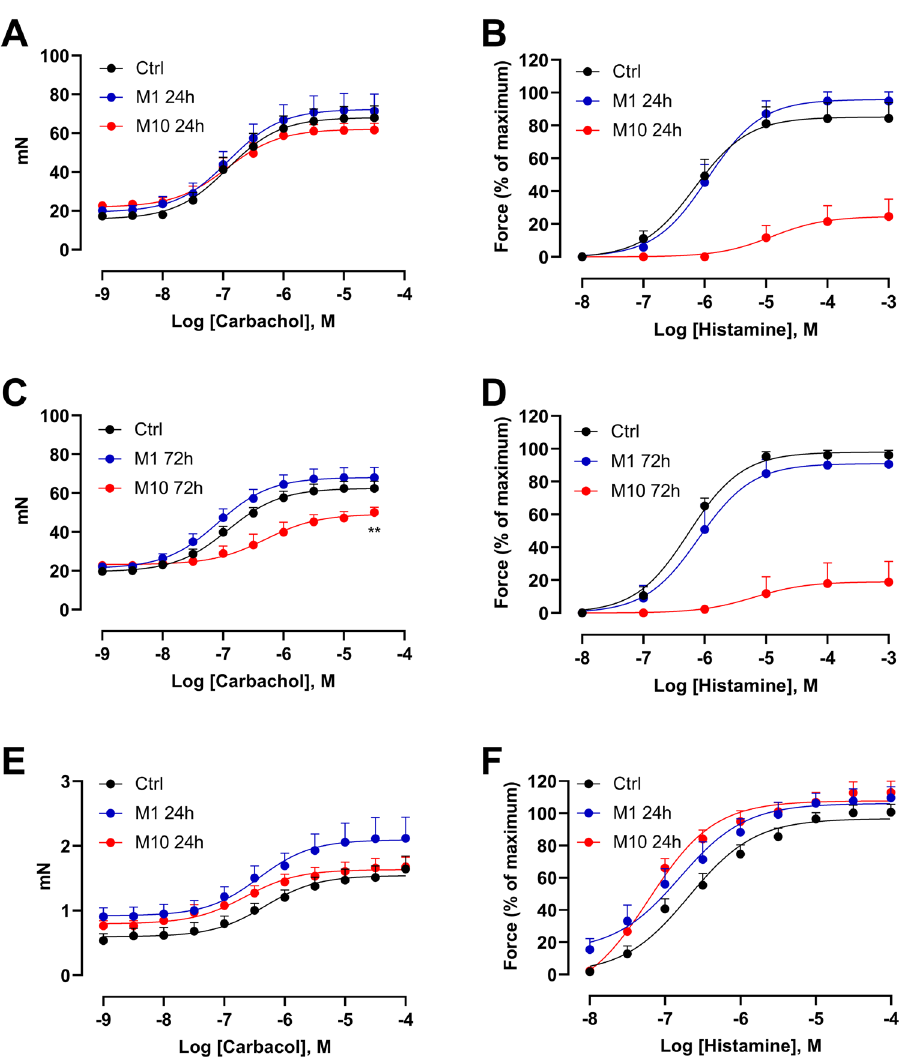
Figure 4. Responses of guinea pig and human airways to carbachol and histamine after monensin exposure. Guinea pig tracheal responses to carbachol after ( A ) 24 h and ( C ) 72 h, and histamine after ( B ) 24 h and ( D ) 72 h exposure to 1 µM (M1) or 10 µM (M10) monensin, or vehicle (1% ethanol; Ctrl). The responses of human bronchi to (E) carbachol and ( F ) histamine after 24 h incubation (n = 6 to 14 per group). ** p <